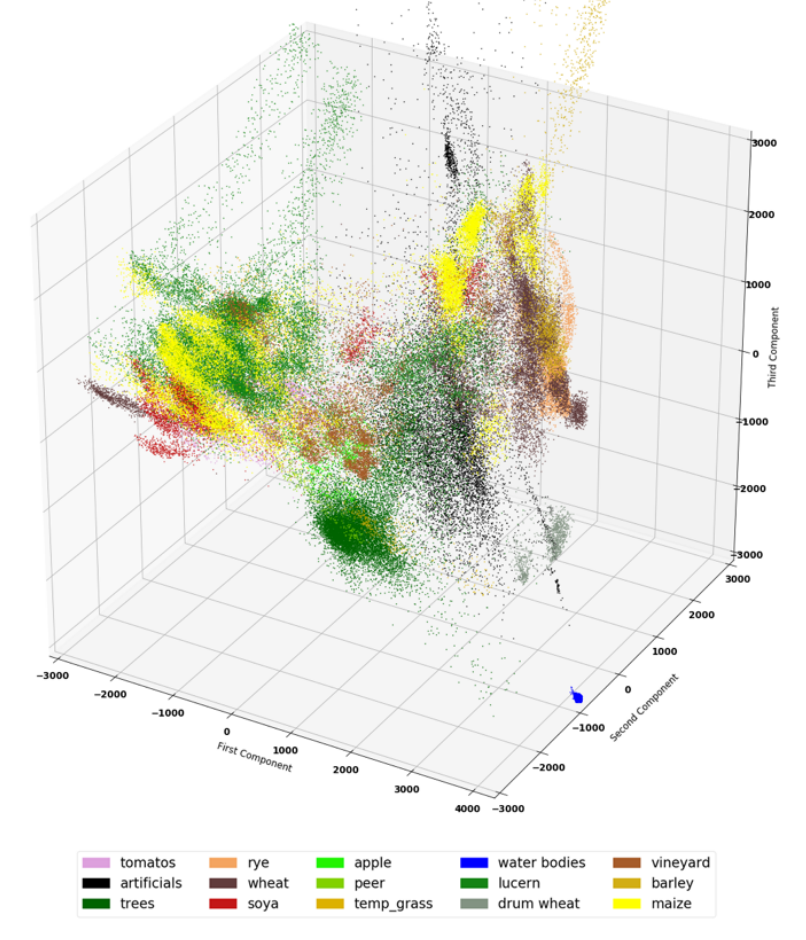
Figure 9. Visual representation of the data points projected in the tri-dimensional space using PCA. The three principal components took into account preserve 64.5% of the original data set variance.